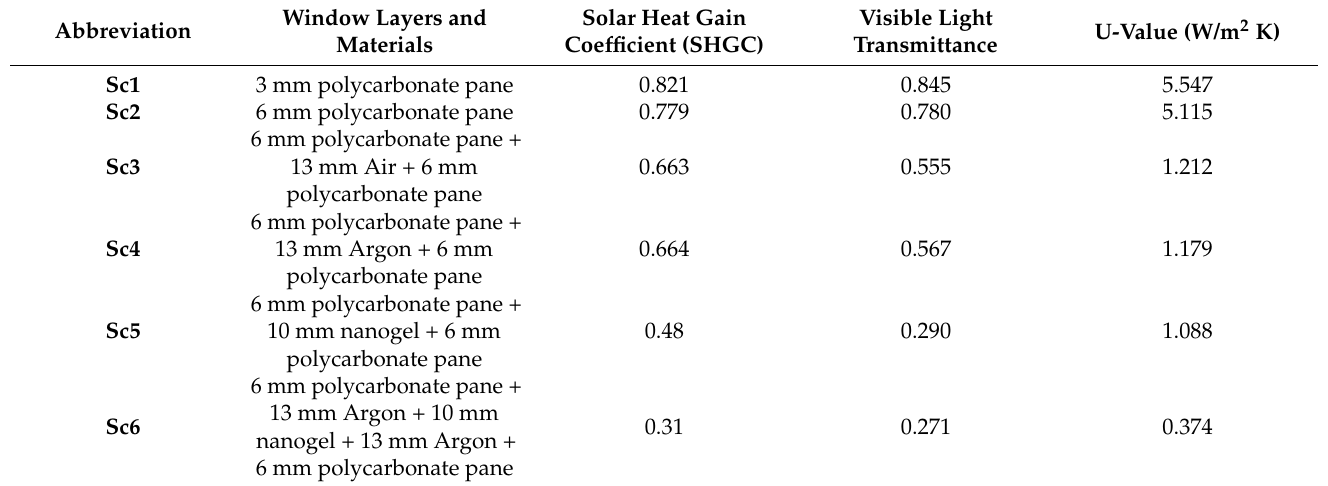
Table 3. Characteristics and attributes of the windows.